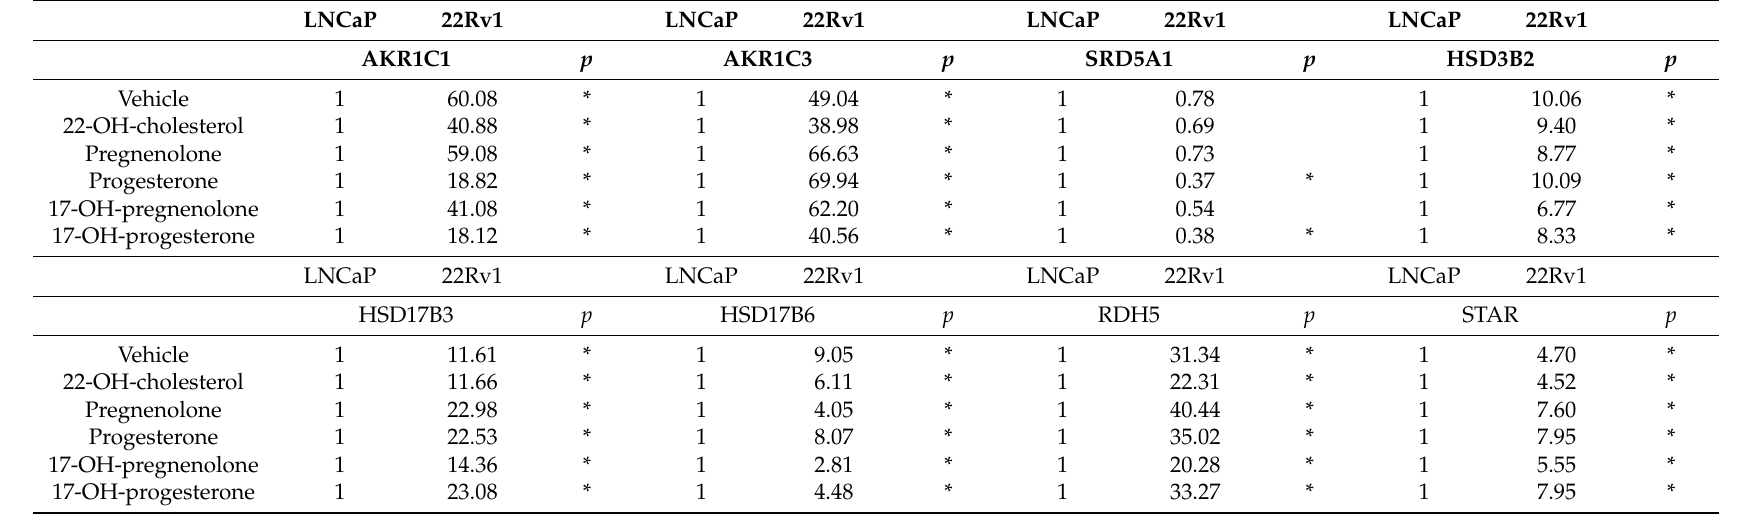
Table 3. A comparison of the messenger RNA (mRNA) levels of the steroid enzymes between LNCaP and 22Rv1 cells after 48 h incubation with 2 µ g/mL 22-OH-cholesterol, pregnenolone, progesterone, 17-OH-pregnenolone or 17-OH-progesterone, or vehicle. Data is normalized to GAPDH mRNA levels, which are assumed to be constant across both cell lines. Data is represented as fold change of LNCaP levels. * represents a statistically significance ( p > 0.05) difference between LNCaP and 22Rv1